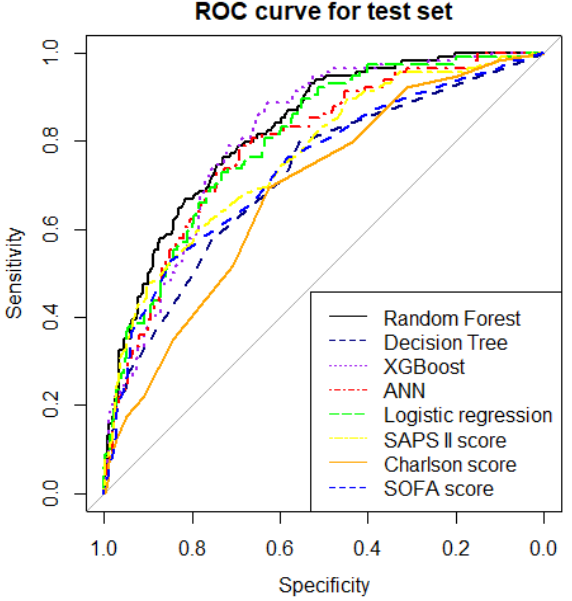
Figure 1. Comparison of AUROC among the different ML models, logistic regression model, SAPS II score, Charlson score, and SOFA score. ROC, operating characteristic.